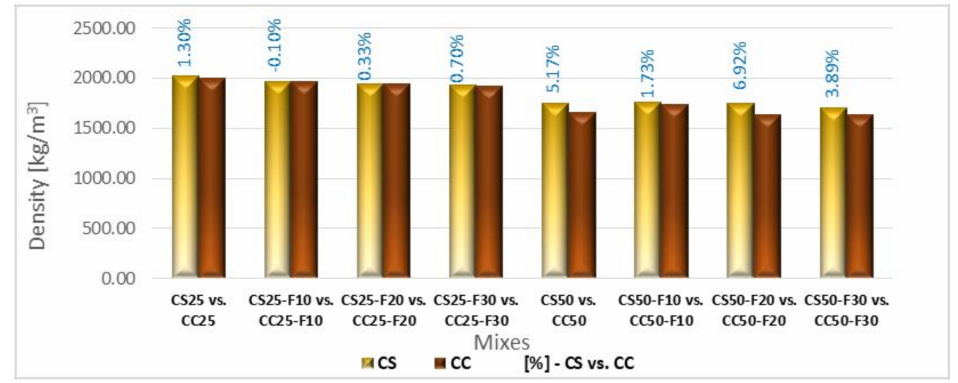
Figure 13. Density variation of composites with aggregates from sunflower stalks versus composites with corn cob aggregates